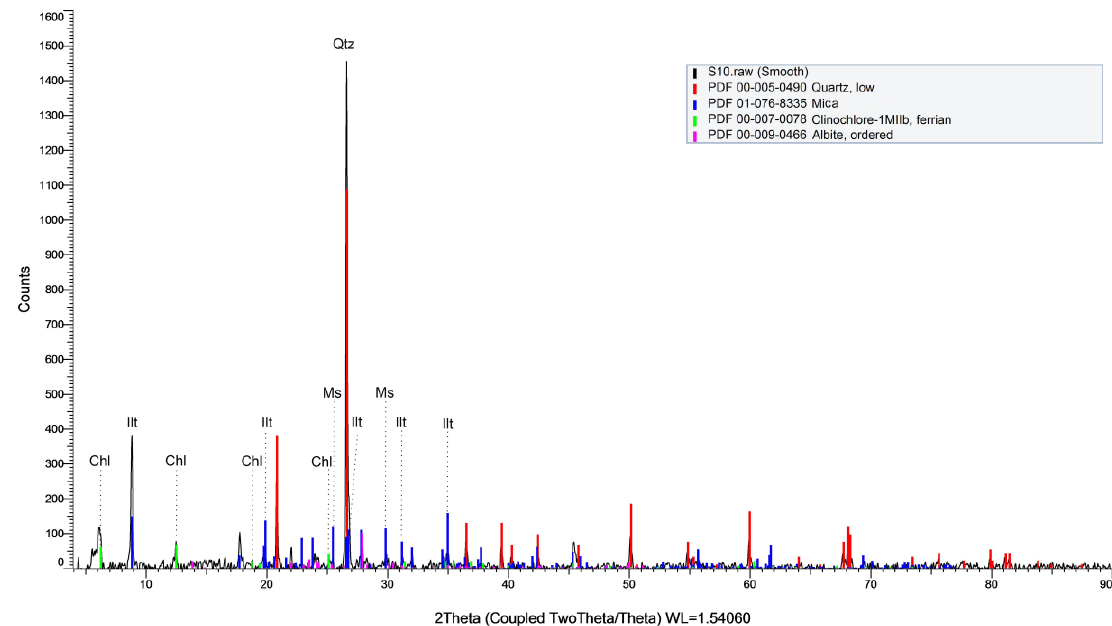
Figure 2. An X-ray powder pattern for a representative sample of soil from Mănăila.